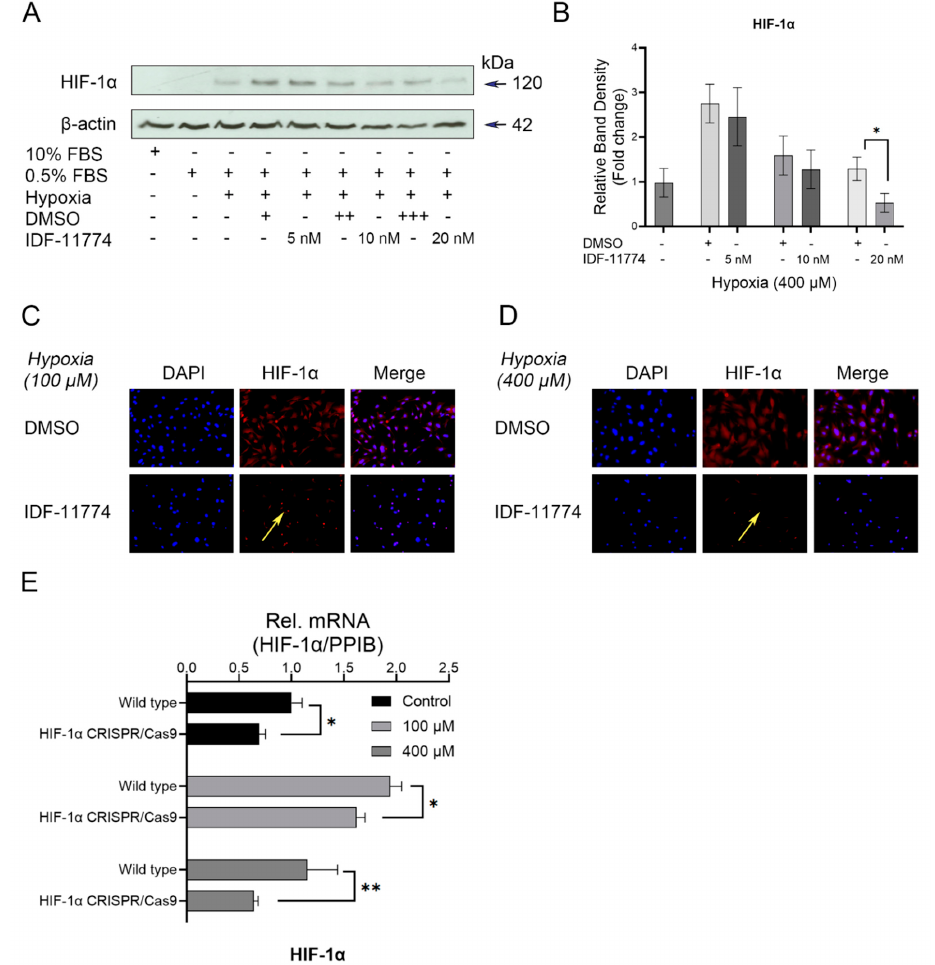
Figure 3. A major role of HIF-1 α inhibition on HIF-1 α expression under hypoxia. Cells were preincu- bated with different concentrations of HIF-1 α inhibitor (IDF11774) for 2 h and then incubated in hypoxic conditions for 24 h, respectively. ( A ) Western blot analysis of the expression levels of HIF-1 α in the presence or absence of IDF-11774 (0, 5, 10, 20 nM). HIF-1 α accumulation was reduced by the increased concentration of IDF-11774. Internal β -actin levels serve as loading control. ( B ) Quantification was performed to detected protein changes of HIF-1 α , and it was demonstrated that its expression is signif- icantly inhibited by the highest concentration of IDF-11774 (20 nM). ( C , D ) Representative IF staining showing the distribution changes of HIF-1 α in hypoxia-treated OCCM-30 cells with the treatment of the pharmacological signaling inhibitor IDF-11774 (20 nM). Yellow arrows indicate the expression of HIF-1 α was effectively inhibited by the HIF-1 α inhibitor IDF-11774. ( E ) Verification of the efficacy of HIF-1 α CRISPR/Cas9 system. Knockdown of HIF-1 α gene expression by CRISPR/Cas9 decreased the hypoxia-induced gene expression of HIF-1 α in OCCM-30 cells. The blots and photomicrographs represent three independent experiments with SD. Statistically significant differences (indicated by asterisks) are indicated as follows (ns, no significant difference; * p < 0.05; ** p <